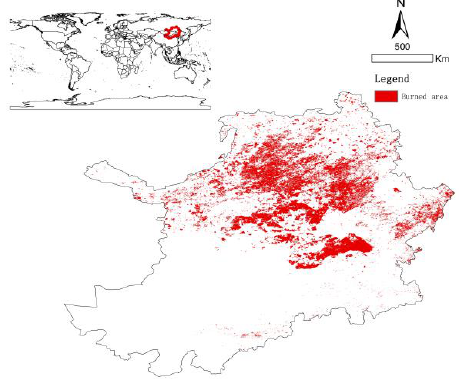
Figure 1. Location of the study site, the red area indicates the area where fires have occurred over the years (2001–2017).